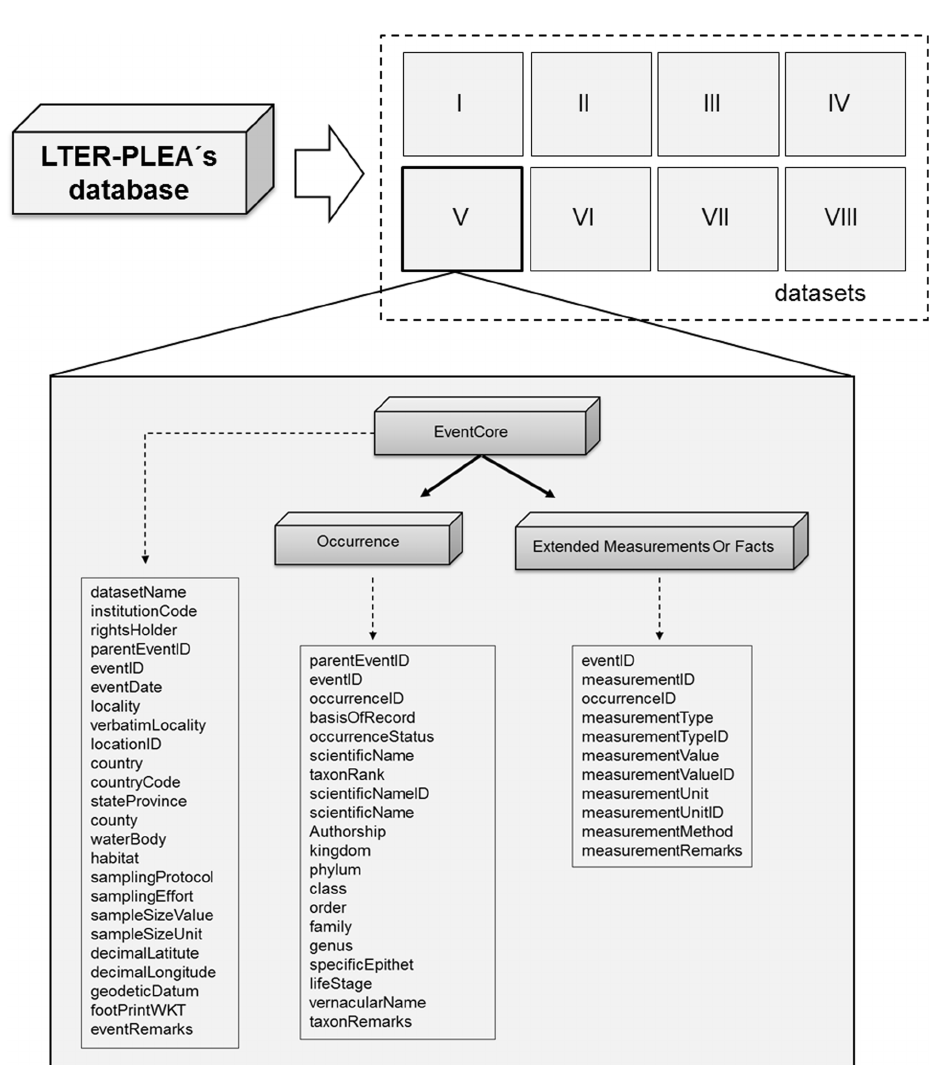
Figure 3. The LTER-PLEA’s dataset structure. The LTER-PLEA’s dataset structure based on the OBIS-ENV-DATA format. Darwin Core terms (https://dwc.tdwg.org/terms/, last access: 10 October 2020) used in each extension are described in the boxes. Dataset I: phytoplankton and water quality parameters in the Patos Lagoon estuary and adjacent marine coast; dataset II: continuous monitoring of the micro- and mesozooplankton of the Patos Lagoon estuary and adjacent coastal area; dataset III: interannual variability in ichthyoplankton diversity in the Patos Lagoon estuary in southern Brazil; dataset IV: dynamics of submerged aquatic vegetation in the Patos Lagoon estuary; dataset V: temporal data series of benthic macrofauna abundance and composition from the Patos Lagoon estuary; dataset VI: ecology of the pink shrimp Penaeus paulensis in Patos Lagoon estuary; dataset VII: species composition and abundance patterns of fish assemblages in shallow waters of Patos Lagoon estuary; dataset VIII: ecology of Lahille’s bottlenose dolphin Tursiops truncatus gephyreus in the Patos Lagoon estuary and adjacent marine